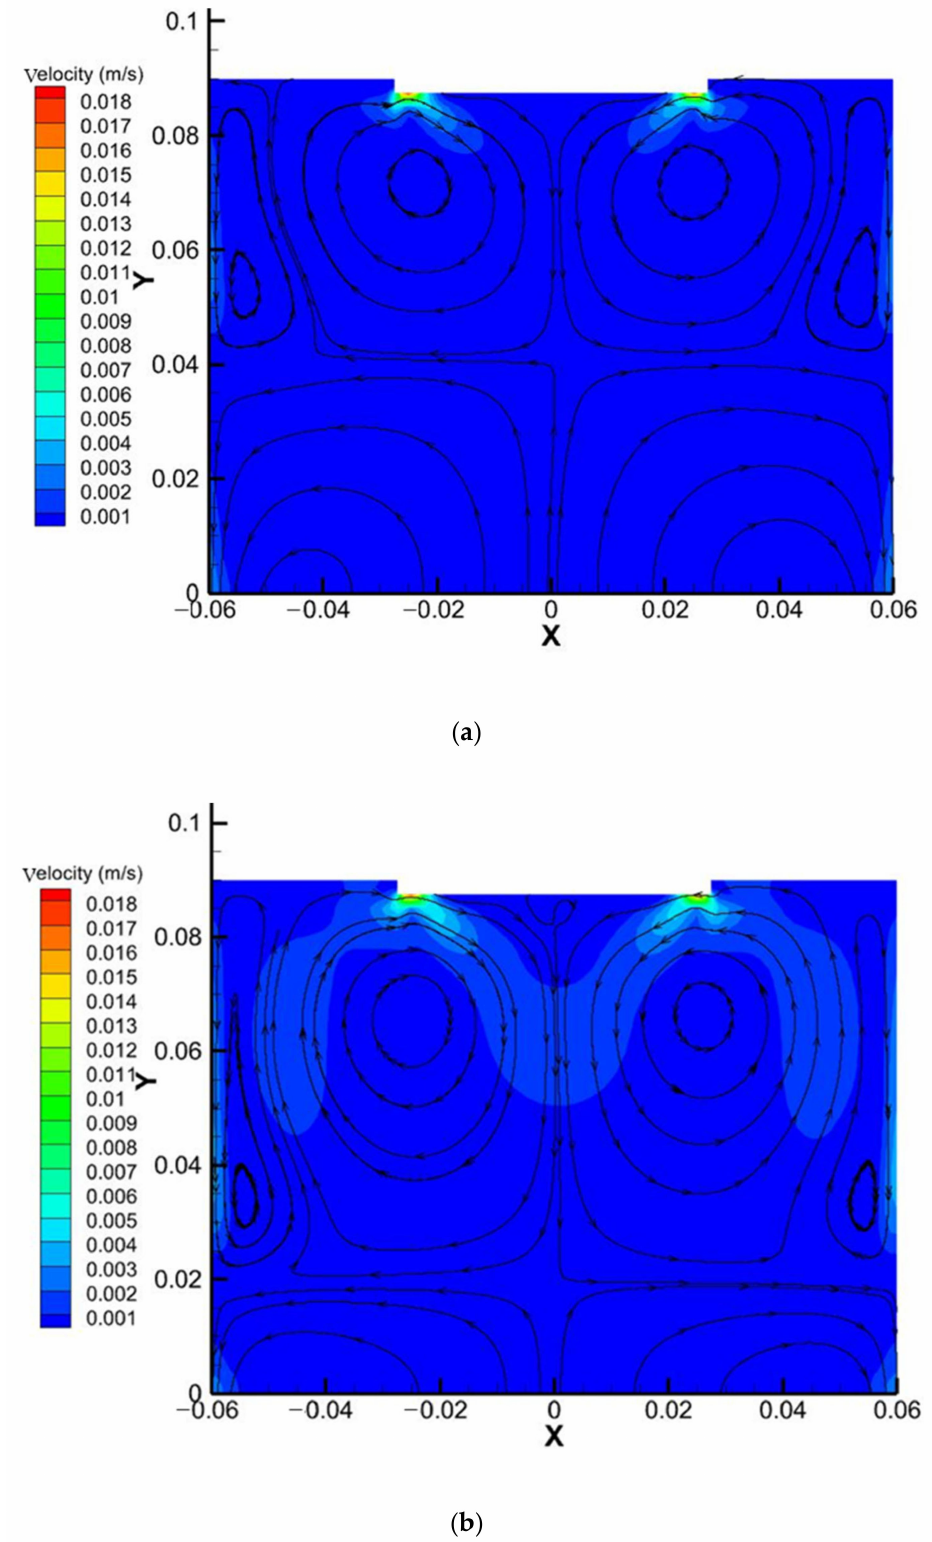
Figure 6. Flow field and streamlines distribution with different slag layer thickness ( a ) 50 mm and ( b ) 70